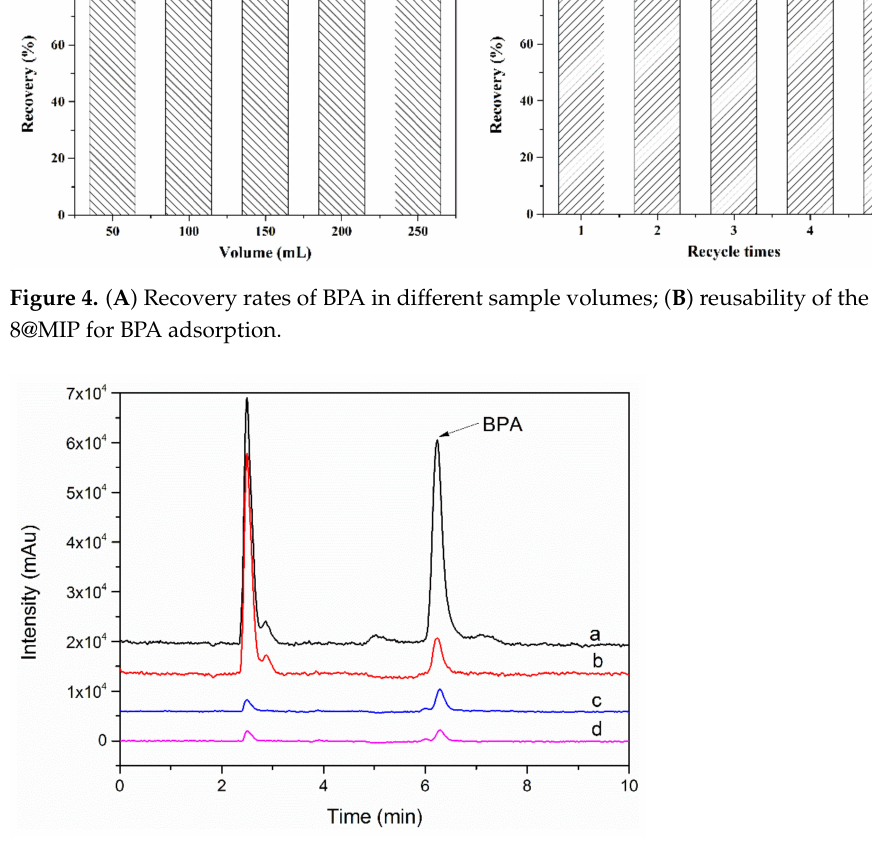
Figure 5. HPLC chromatograms of BPA after enrichment by Fe 3 O 4 @ZIF-8@MIP (a), Fe 3 O 4